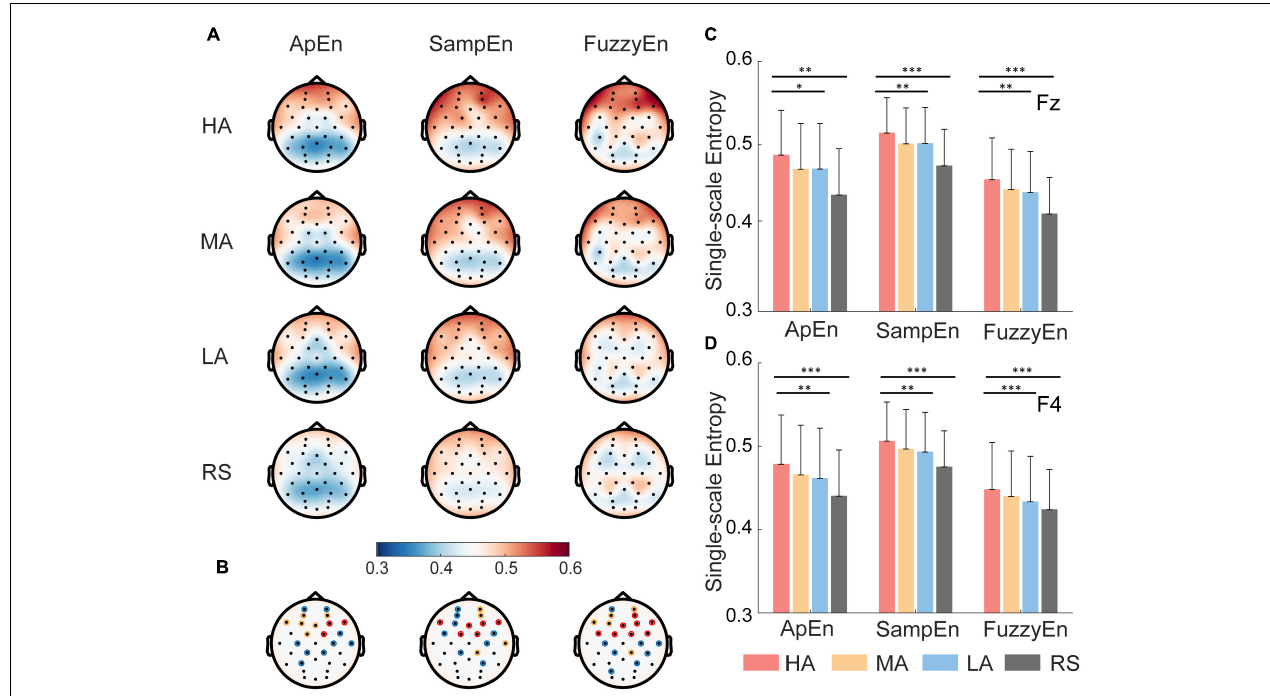
FIGURE 4 | Brain topography and representative results of single-scale EEG complexity. (A) Topography of approximate entropy (ApEn), sample entropy (SampEn), and fuzzy entropy (FuzzyEn) for all 42 subjects at four attention states (i.e., high attention—HA, medium attention—MA, low attention—LA, and resting state—RS). The red color means high entropy, and blue means low entropy. (B) The statistical significance of 32 channels using Kruskal-wallis test. The color of circle indicates significance level α , blue represents α in the range of (0.01, 0.05], yellow represents α in the range of (0.001, 0.01], red represents α smaller than 0.001. (C,D) Representative results of single-scale complexity measured group differences for three attention levels (HA, MA, and LA) and four different attention levels (HA, MA, LA, and RS) in frontal region at Fz and F4. Nonparametric Kruskal-Wallis test, ∗ p < 0.05, ∗∗ p < 0.01, ∗∗∗ p < 0.001. Error bars = ± 1 SD.